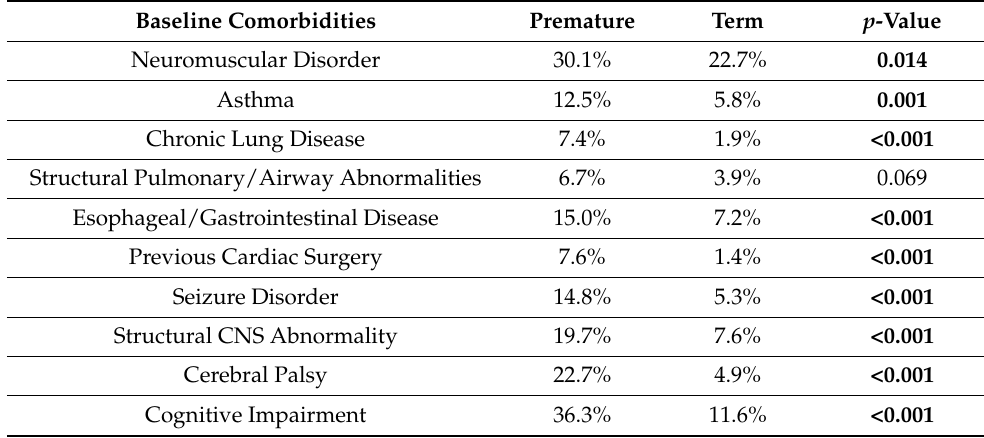
Table 2. Baseline comorbidities of propensity-score matched premature and term AIS patients who underwent PSF from 2012–2016. Bold values are statistically significant ( p <